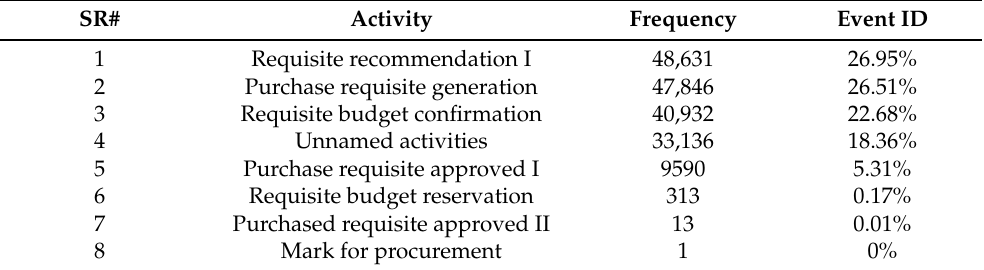
Table 3. Activities